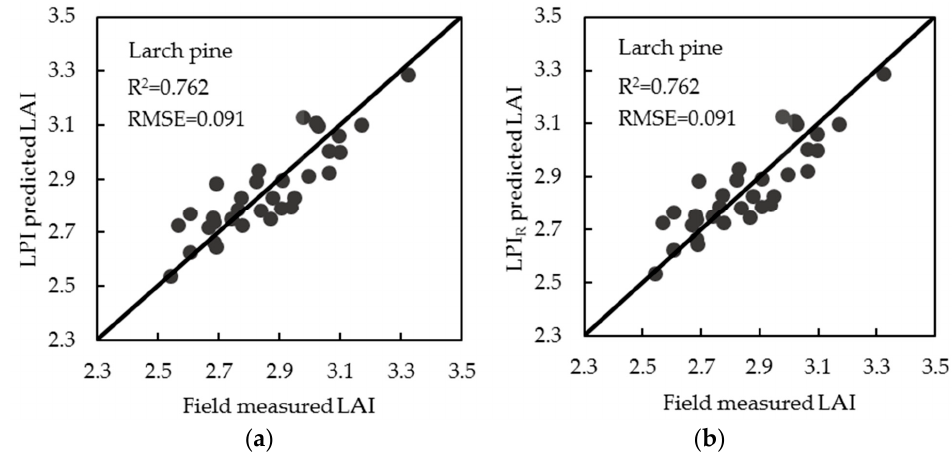
Figure 5. The 1:1 relationship between the field-measured LAI and LiDAR-predicted LAI for Larch pine forests based on: ( a ) the raw intensity data (i.e., LPI); ( b ) the range-normalised intensity data (i.e., LPI R ). R 2 and RMSE are values from leave-one-out cross-validation.